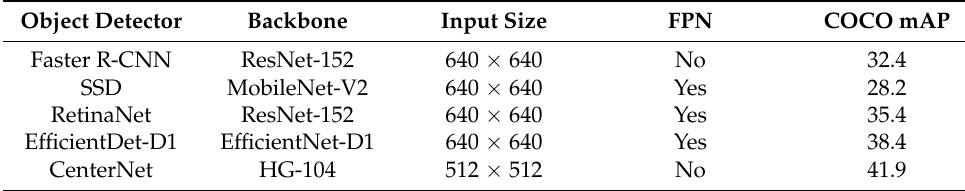
Table 1. The selected object detection architectures used for the experiment.